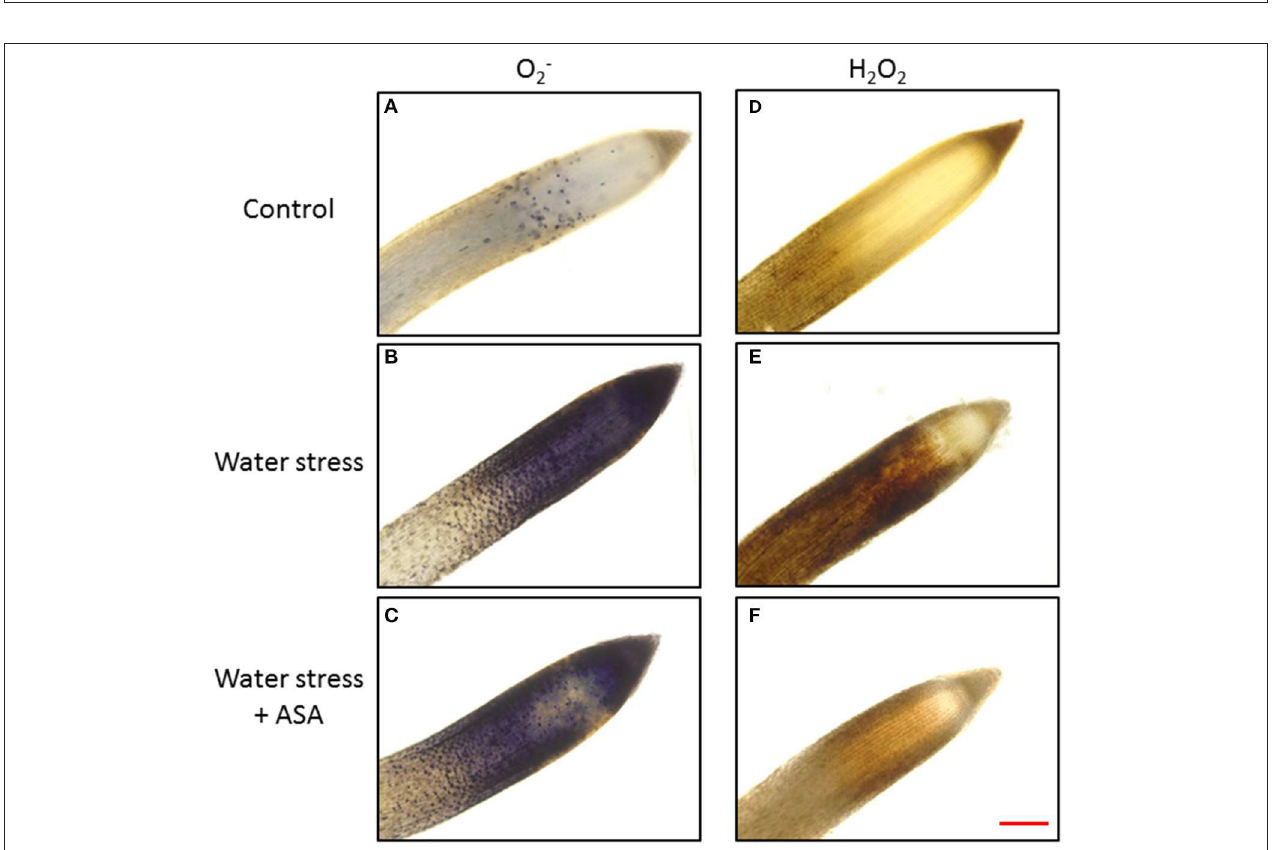
FIGURE 3 | The content of super oxide (O − 2 ) (A) and hydrogen peroxide (H 2 O 2 ) (B) in roots of tall fescue exposed to non-stress control, water stress, and water stress with ASA treatment. The data represent mean ± SE ( n = 4 replicated pots of plants and each pot with multiple plants). Columns marked with the same letter are not significantly different at p < 0.05 .